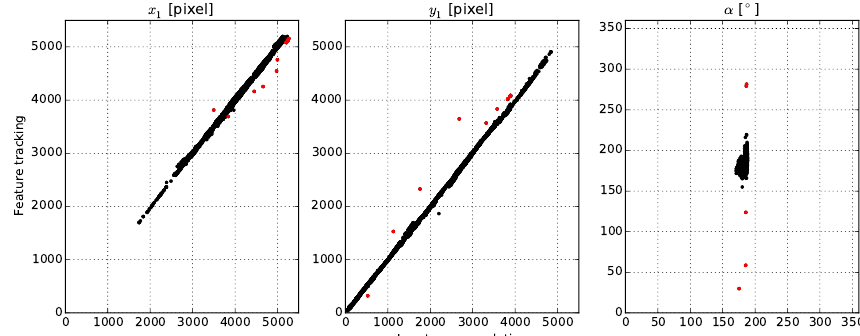
Figure 5. Filter process applied to image pair Fram Strait in HV polarisation. The x axis represents the simulated start position and rotation, derived from f (x 2f , y 2f , b ) and the y axis represents the feature-tracking start position x 1f , y 1f and rotation α f . NB The image rotation is δ = 129.08 ◦ , which means the rotation was adjusted by 50.92 ◦ (Eq. 3). Red points were identified as outliers and deleted.